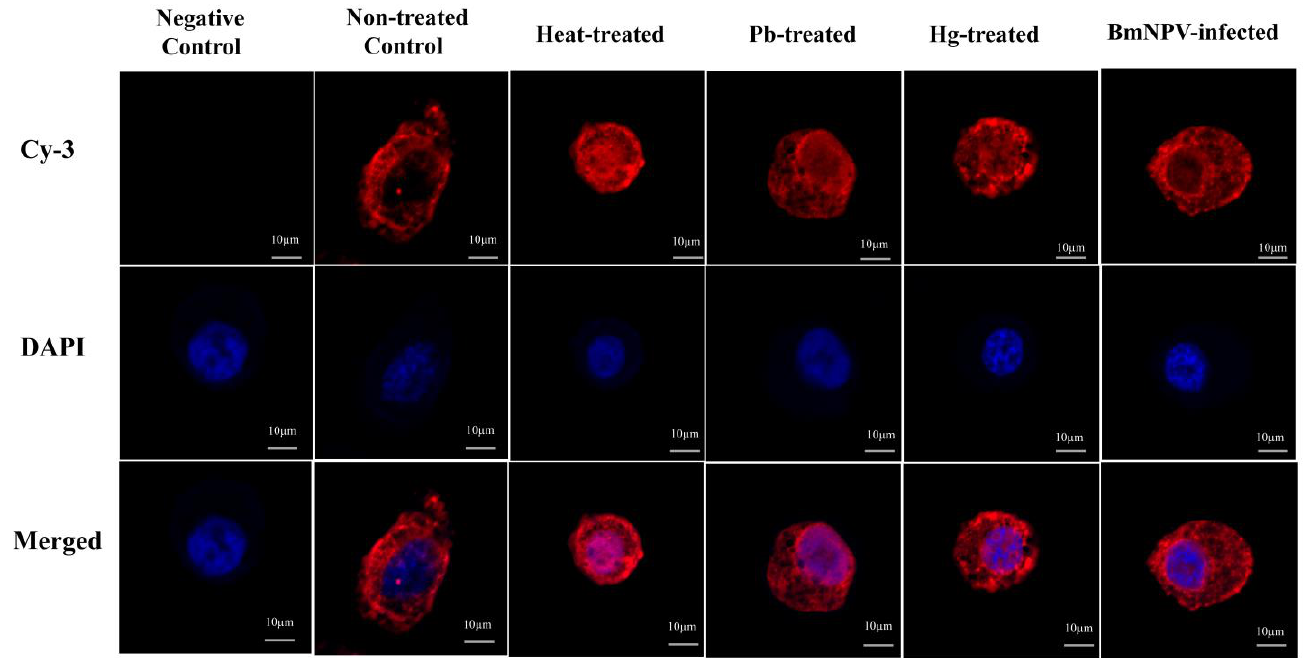
Figure 7. Subcellular localization of BmGRP78 in BmN cells under different stress-induced conditions. Subcellular localization of BmGRP78 with Cy3-labled secondary antibody and DAPI. The fluorescent signal was imaged by confocal microscopy. Immunostaining with anti-BmGRP78 antibody, DAPI blue fluorescence, merged images, and the negative control group are shown.